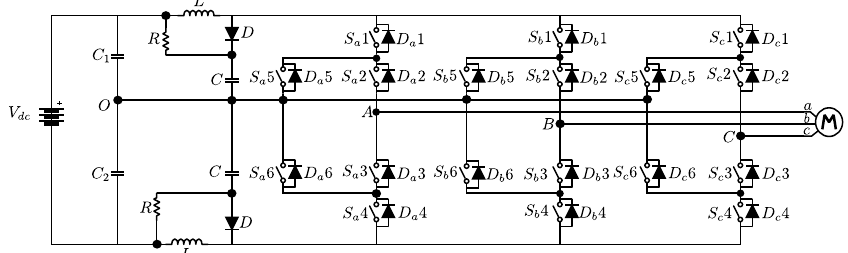
Figure 18. Active NPC. Open-switch and short-circuit faults are faced by proper bidirectional switches reconfiguration. For instance, when S a 1 open failure occurs at the positive stage, the AC phase output is connected to neutral-point ( O ) of DC link instead of positive DC bus by S a 2 and S a